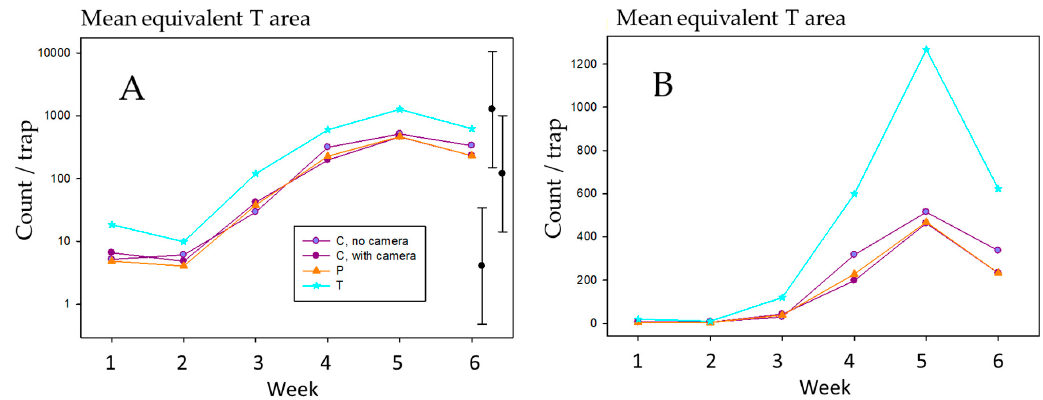
Figure 3. Corrected mean weekly count of Thrips obscuratus by trap type per standard 56 cm 2 Delta trap (T) opening from 8 December 2013–12 January 2014 at Clyde Research Orchard. ( A ) Log scale. Error bars show confidence limits for the smallest, largest, and a mid-range mean within the plot. ( B ) x -axis on normal scale. Confidence limits are omitted on the count scale, as the highest limit is very large relative to the means, and the patterns amongst means are therefore obscured. T is the Delta trap, P is prototype, and C is the camera trap.